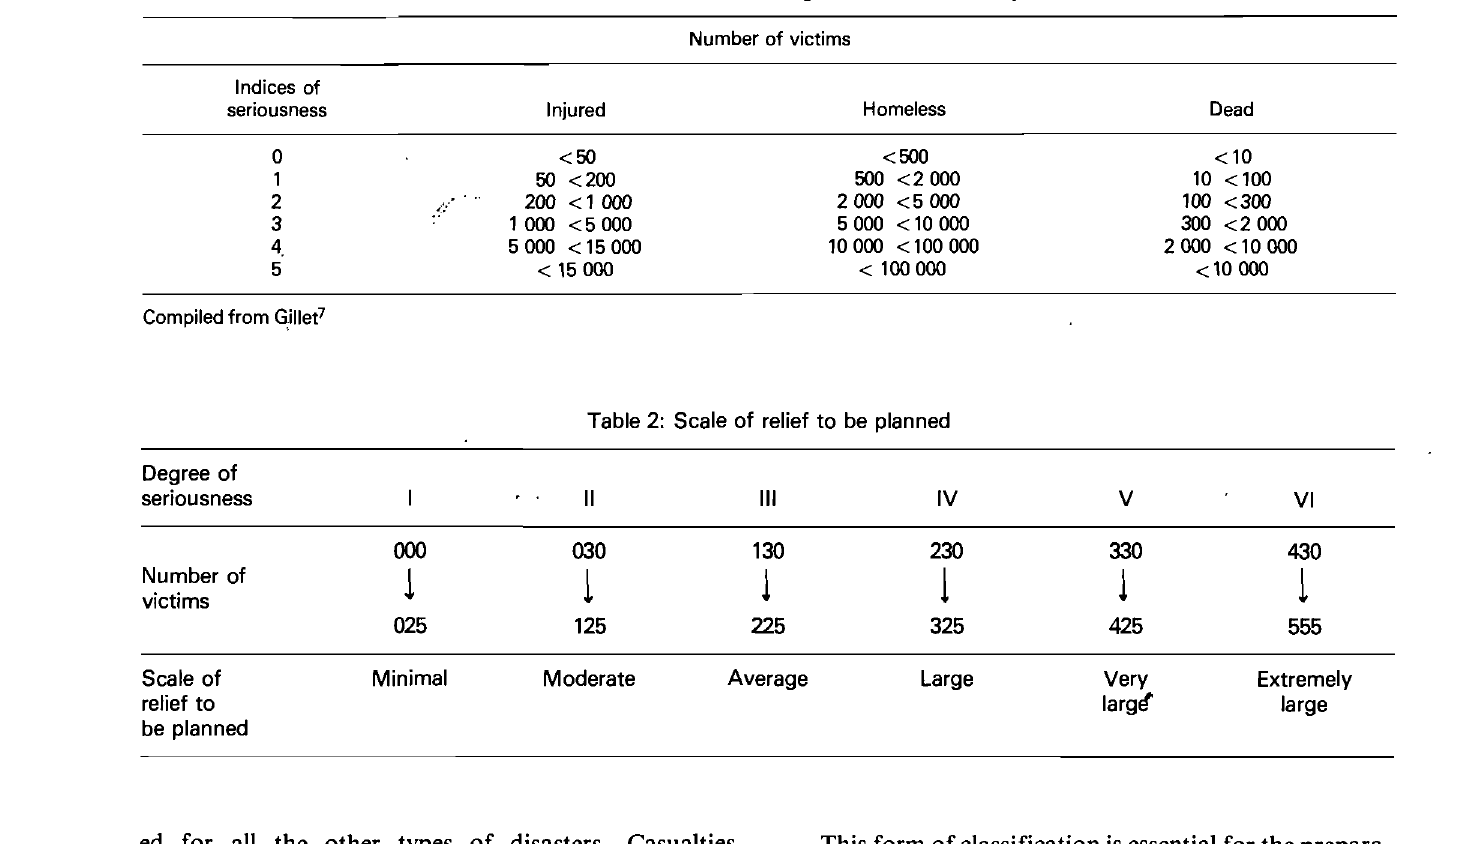
Table 2: Scale of relief to be